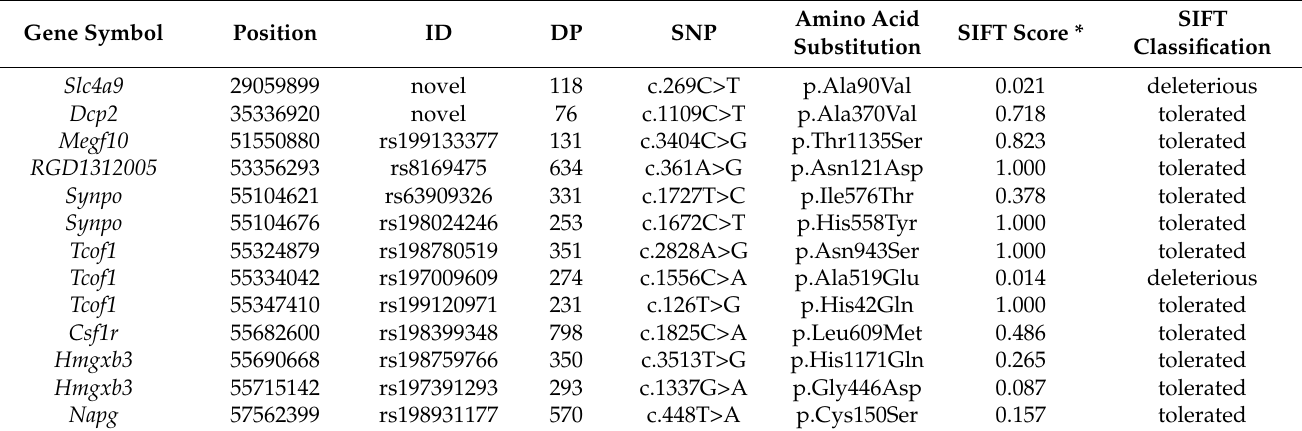
Table 6. Predicting the effects of missense variants on protein function using the Sorting Intolerant From Tolerant (SIFT)